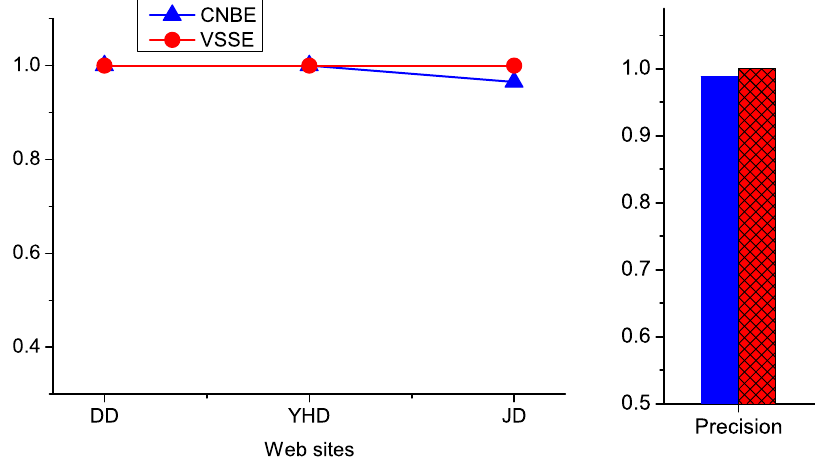
Fig. 13 Extraction performance on http://jd.com